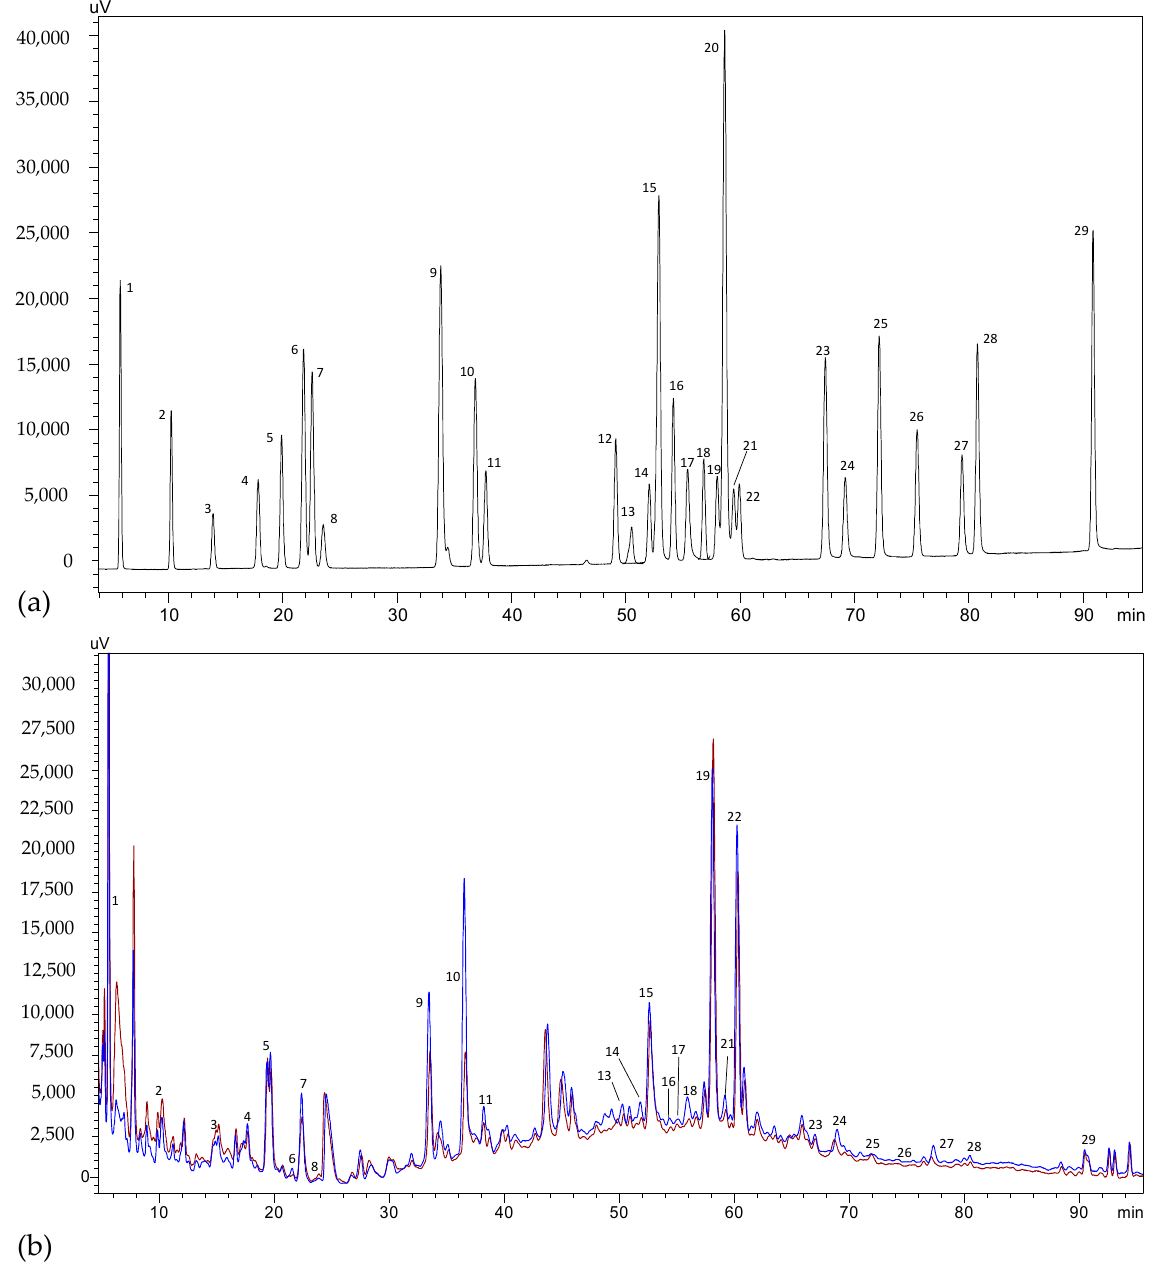
Figure 1. HPLC-PDA chromatogram monitored at 280 nm for ( a ) polyphenol standard mixture of 5 mg/L and for ( b ) salicornia extract (blue and brown lines correspond to CE and MAE extracts, respectively); peak identification: (1) gallic acid, (2) protocatechuic acid, (3) (+)-catechin, (4) chlorogenic acid, (5) vanillic acid, (6) caffeic acid, (7) syringic acid, (8) ( − )-epicatechin, (9) p -coumaric acid, (10) trans -ferulic acid, (11) sinapic acid, (12) naringin, (13) 3,5-di- O -caffeoylquinic acid, (14) quercetin-3- O -galactoside, (15) rutin, (16) phloridzin, (17) ellagic acid, (18) 3,4-di- O -caffeoylquinic acid; (19) myricetin, (20) cinnamic acid, (21) kaempferol-3- O -glucoside, (22) kaempferol-3- O -rutinoside, (23) naringenin, (24) quercetin, (25) phloretin, (26) tiliroside, (27) kaempferol, (28) apigenin and (29)